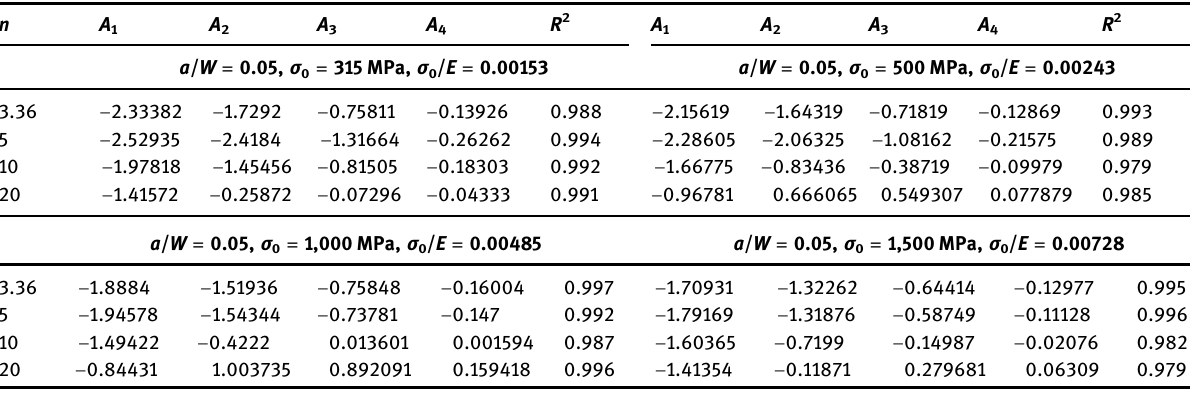
Table 11: Coe ffi cients of matching formula ( 33 ) to the numerical results for the estimation of the Q stress values, for SEN ( 4PB ) specimens dominated by the plane strain state, with the relative crack length a / W = 0.05 n A